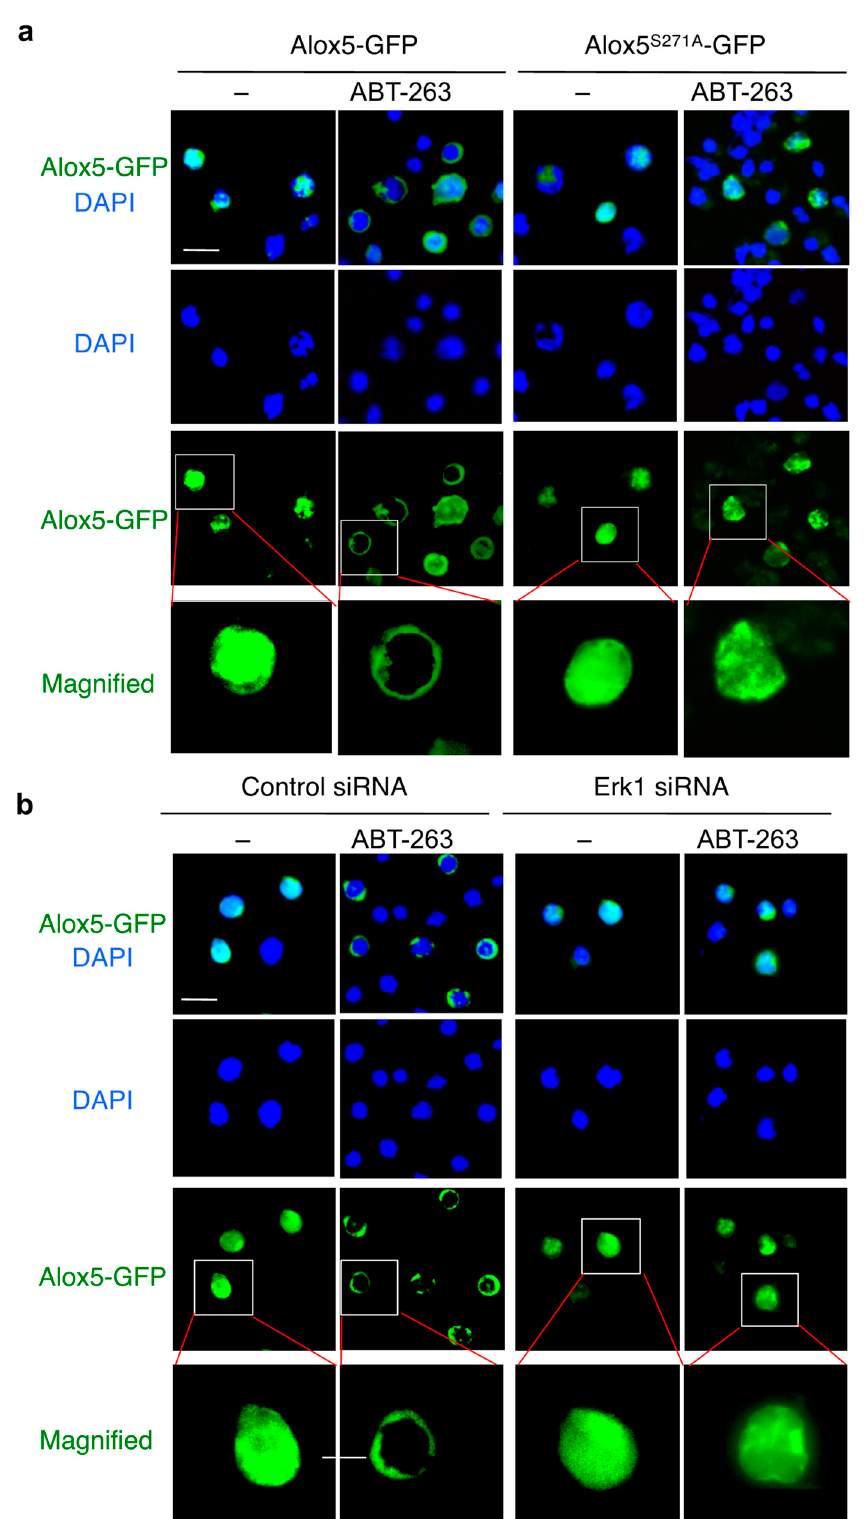
Figure 7. Regulation of Alox5 nuclear localization by Erk1. ( a ) JMR cells were transfected with Alox5-GFP or Alox5 S271A -GFP. After 24 h culture, the cells were treated with ABT-263 for 9 h. The cells were added to slides by cytospin and stained with DAPI, followed by fluorescent microscopy. Scale bar, 10 μ m. ( b ) JMR cells were transfected with Erk1 or control siRNA. After 24 h culture, the cells were transfected with Alox5-GFP and cultured for another 24 h. The cells were then treated with ABT-263 for 9 h and analyzed by fluorescent microscopy. Scale bar, 10 μ m.